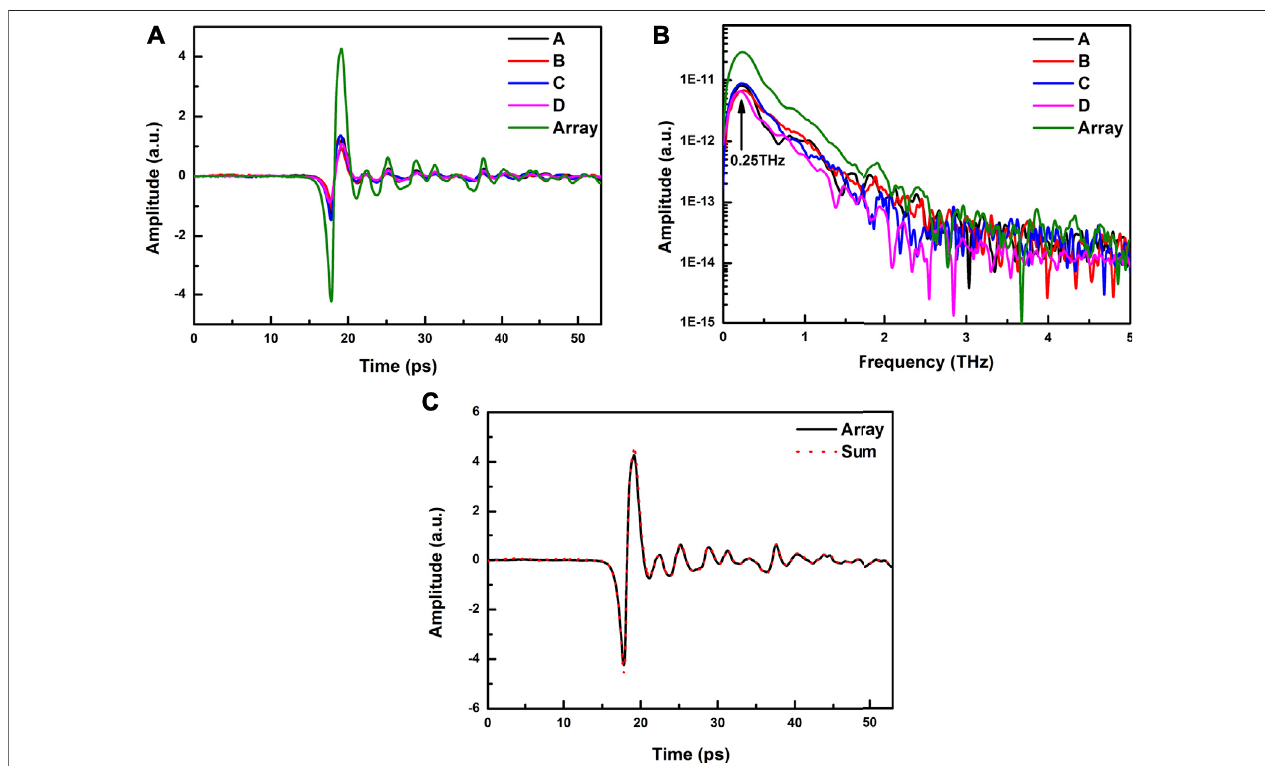
FIGURE 2 | Terahertz wave was detected by photoconductive antenna array: (A) Time-domain signals of antenna elements and array; (B) Frequency domain signals of antenna elements and array; (C) Synthesis ef fi ciency of the antenna array.